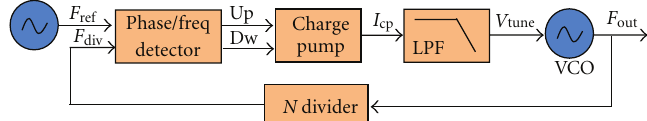
Figure 2: PLL architecture.